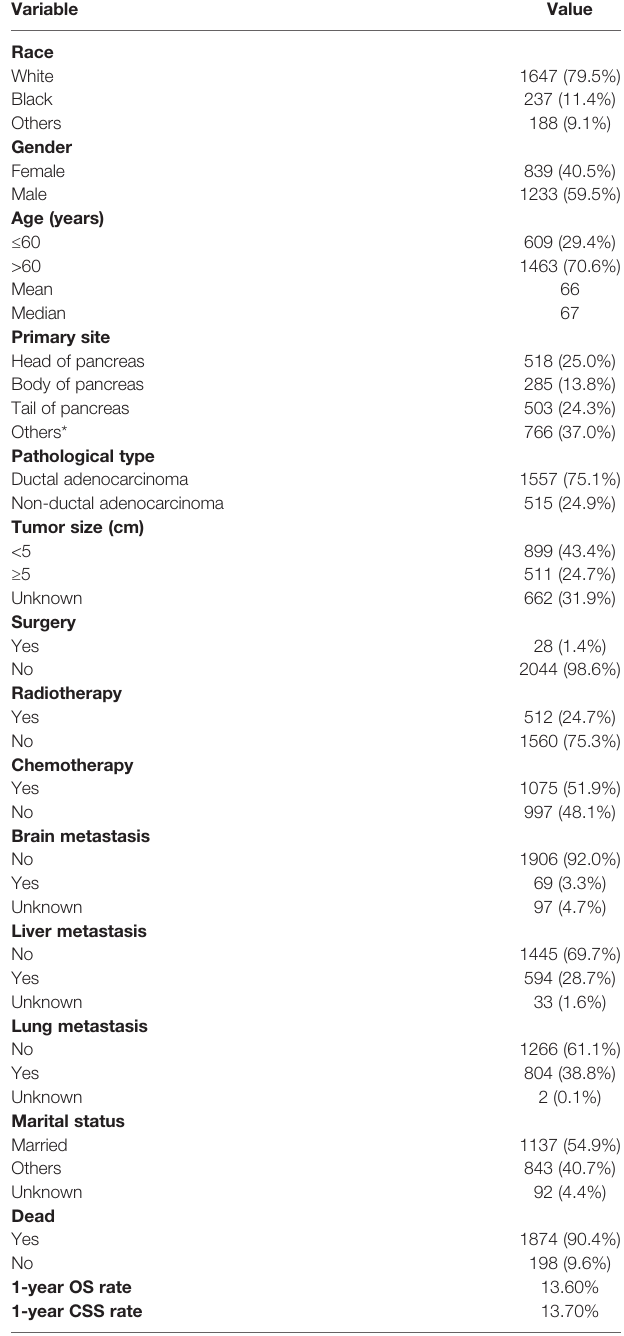
TABLE 1 | Characteristics of 2072 patients with pancreatic cancer bone